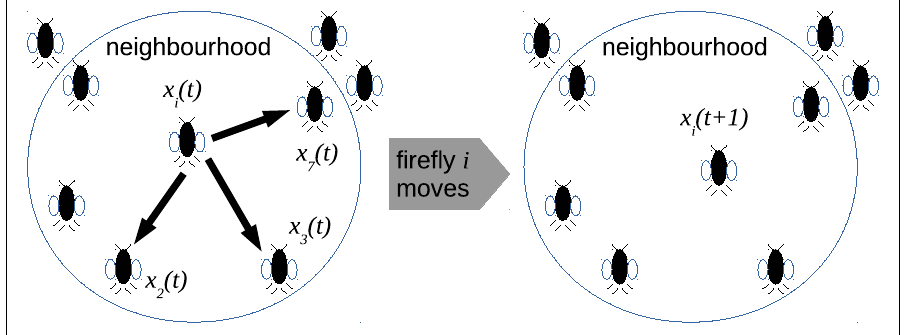
Figure 4. The firefly i moves towards the neighbours brighter than it (fireflies 2, 3 and 7 in this